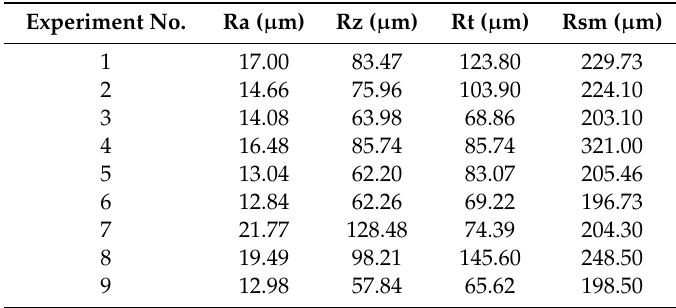
Table 5. Surface roughness